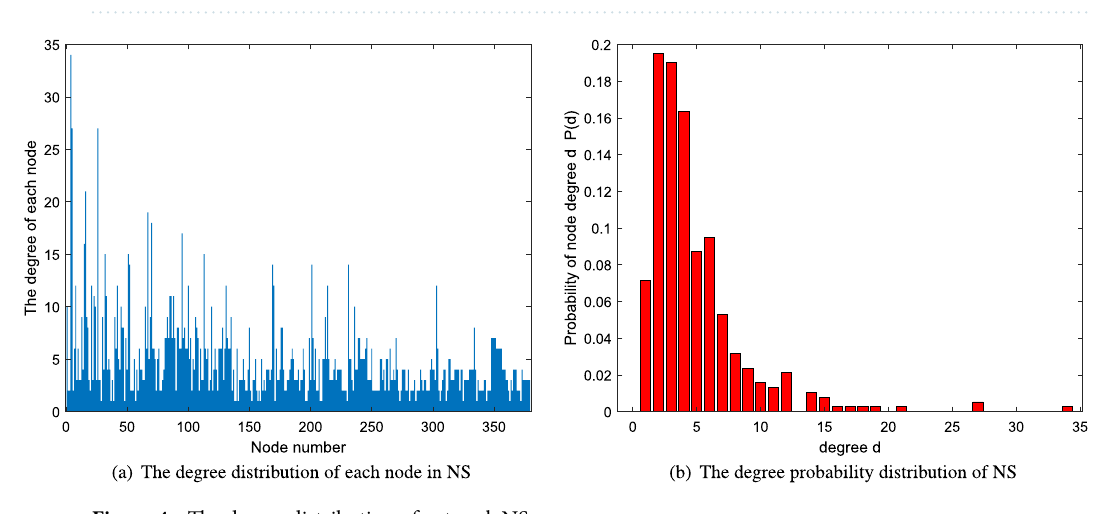
Figure 4. The degree distribution of network